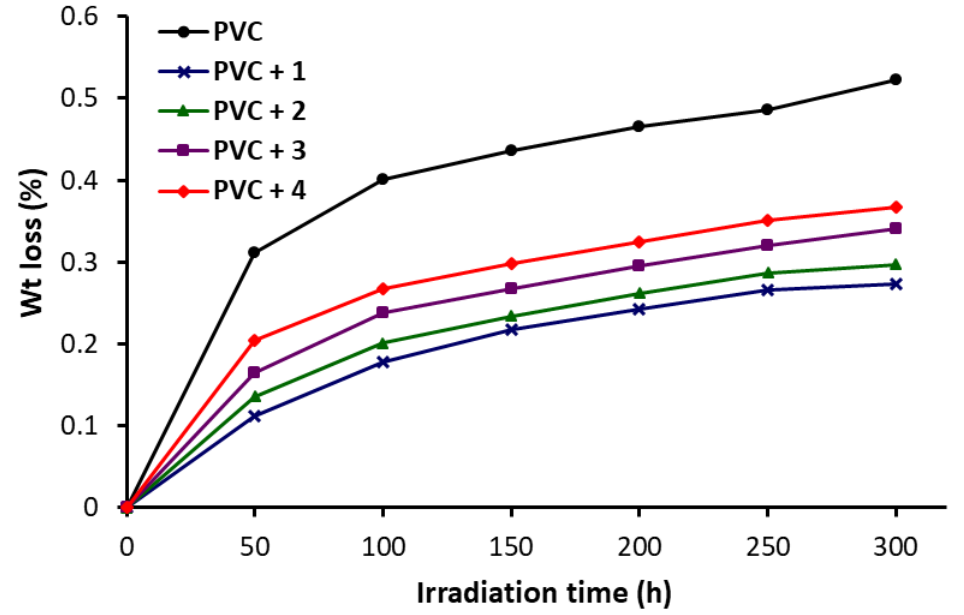
Figure 1. Effect of UV irradiation time on weight loss % of PVC films.